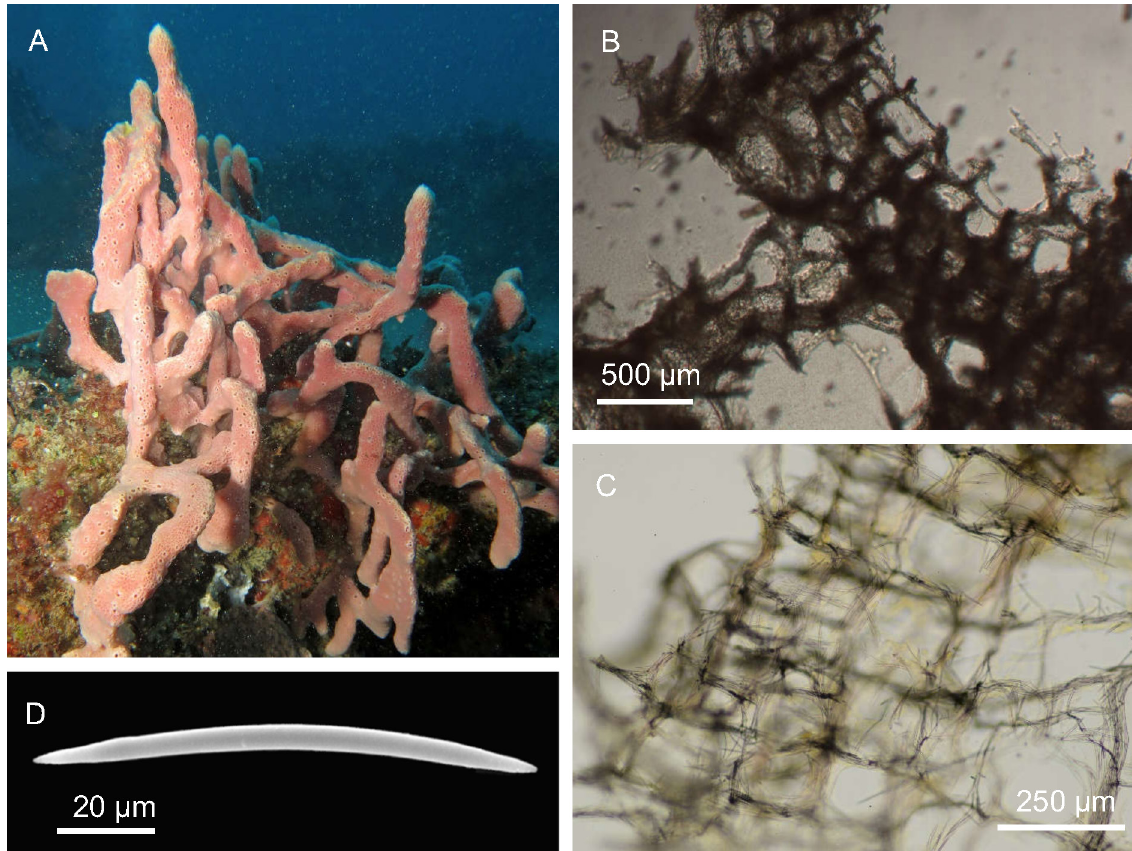
Fig. 9. Amphimedon brevispiculifera (Dendy, 1905). A . Specimen PO65 in situ . B . Ectosomal skeleton. C . Choanosomal skeleton. D .